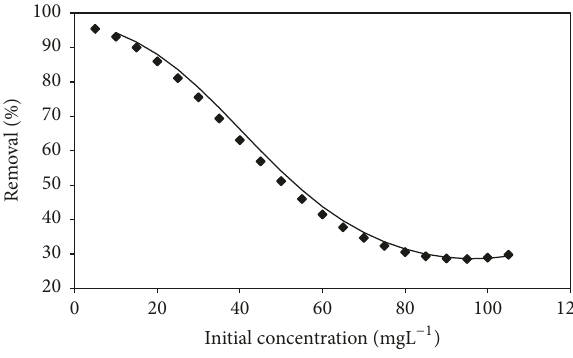
Figure 7: Effect of initial concentration.